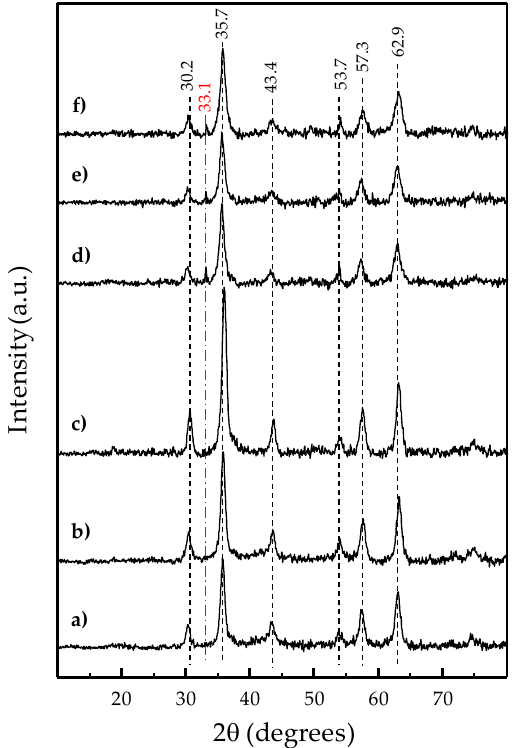
Figure 1. XRD patterns of magnetite solids prepared by coprecipitation employing a Fe 3 + / Fe 2 + aqueous molar ratio of 2 ( a – c ) or 4 ( d – f ), at different synthesis temperatures: 110 °C ( a , d ), 95 °C ( b , e ), or 80 °C ( c,f ). Symbols: Fe 3 O 4 (- - -), α -Fe 2 O 3 (- · - · ‒).